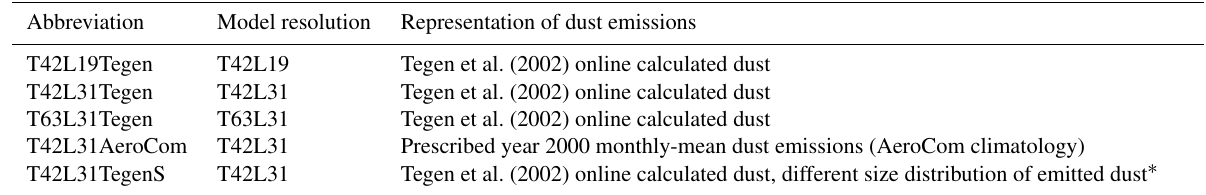
Table 1. Summary of the different EMAC simulation setups applied in this study. All simulations cover the years 2000–2013.